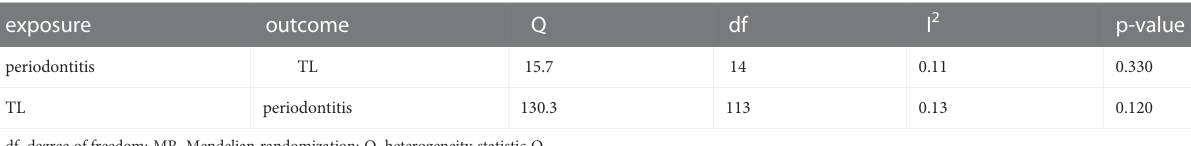
TABLE 2 Heterogeneity of wald ratios.